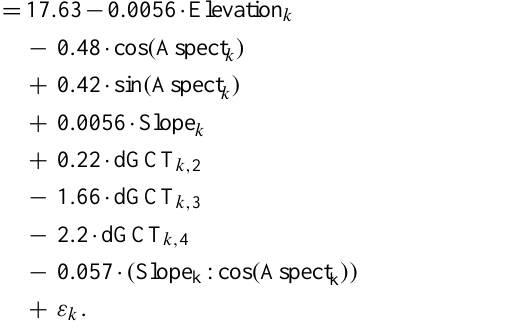
Fig. 7. Scatterplot of measured and fitted MAGST of Model (3). The dashed red line indicates the diagonal y = x . The model ex- plains 93% of the variability of measured MAGST.